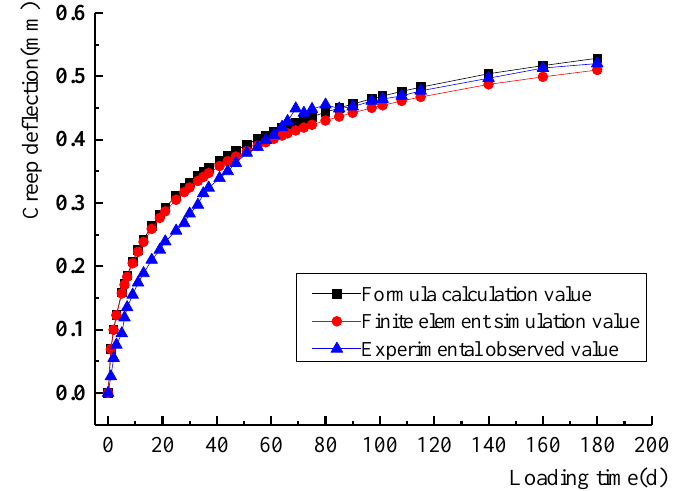
Figure 7. Creep-time curve of specimen TBB2.